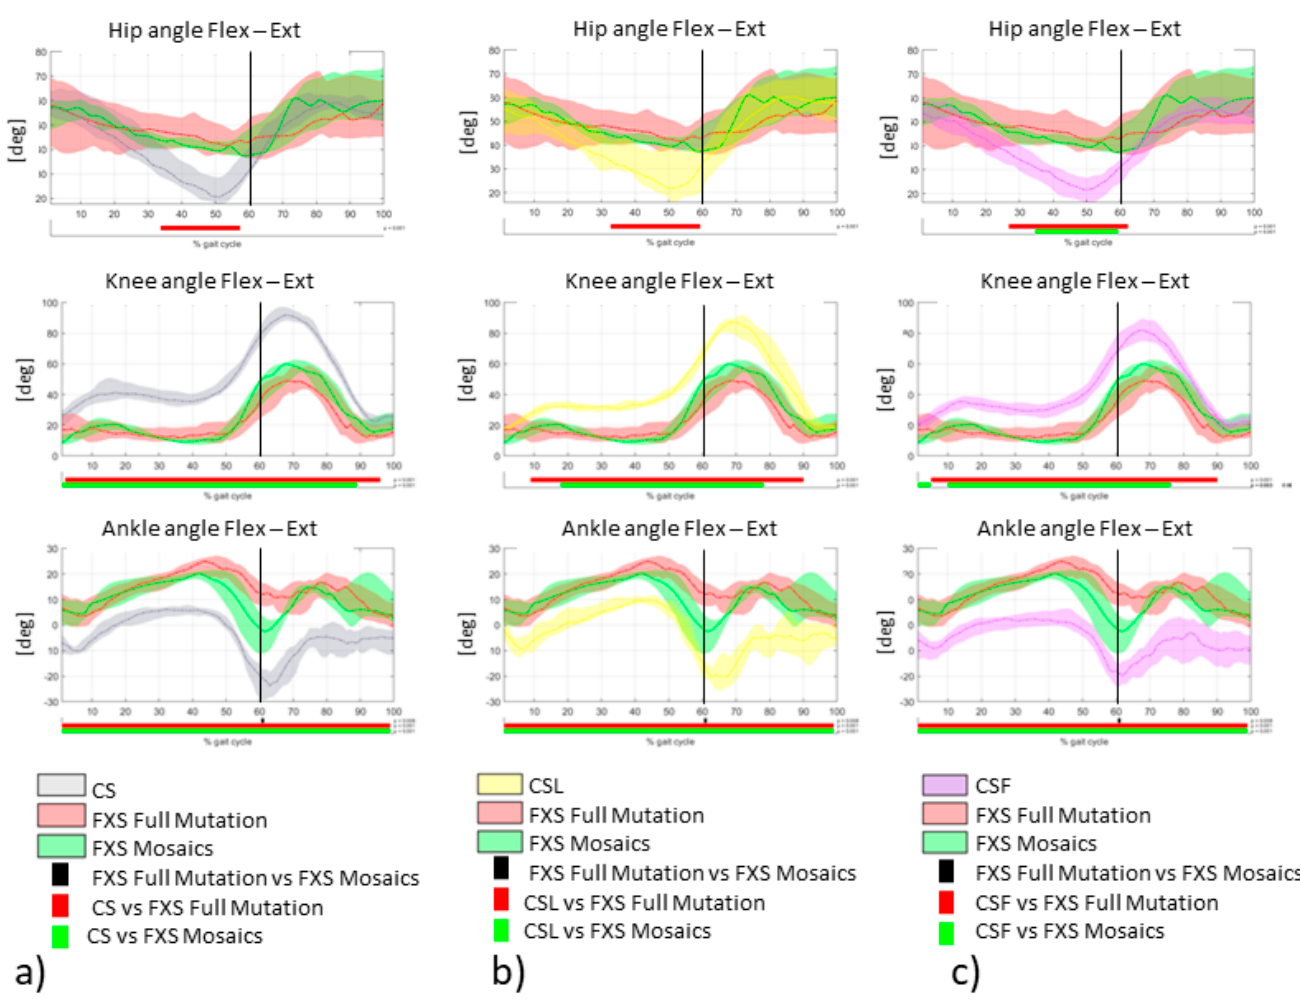
Figure 3. Hip, knee and ankle sagittal plane angles between CS vs. FXS Full Mutation vs. FXS Mosaics ( a ), CSL vs. FXS Full Mutation vs. FXS Mosaics ( b ), CSF vs. FXS Full Mutation vs. FXS Mosaics ( c ); median, 25th and 75th percentile are represented; horizontal bars represent clusters with significant differences (SPM t -test).